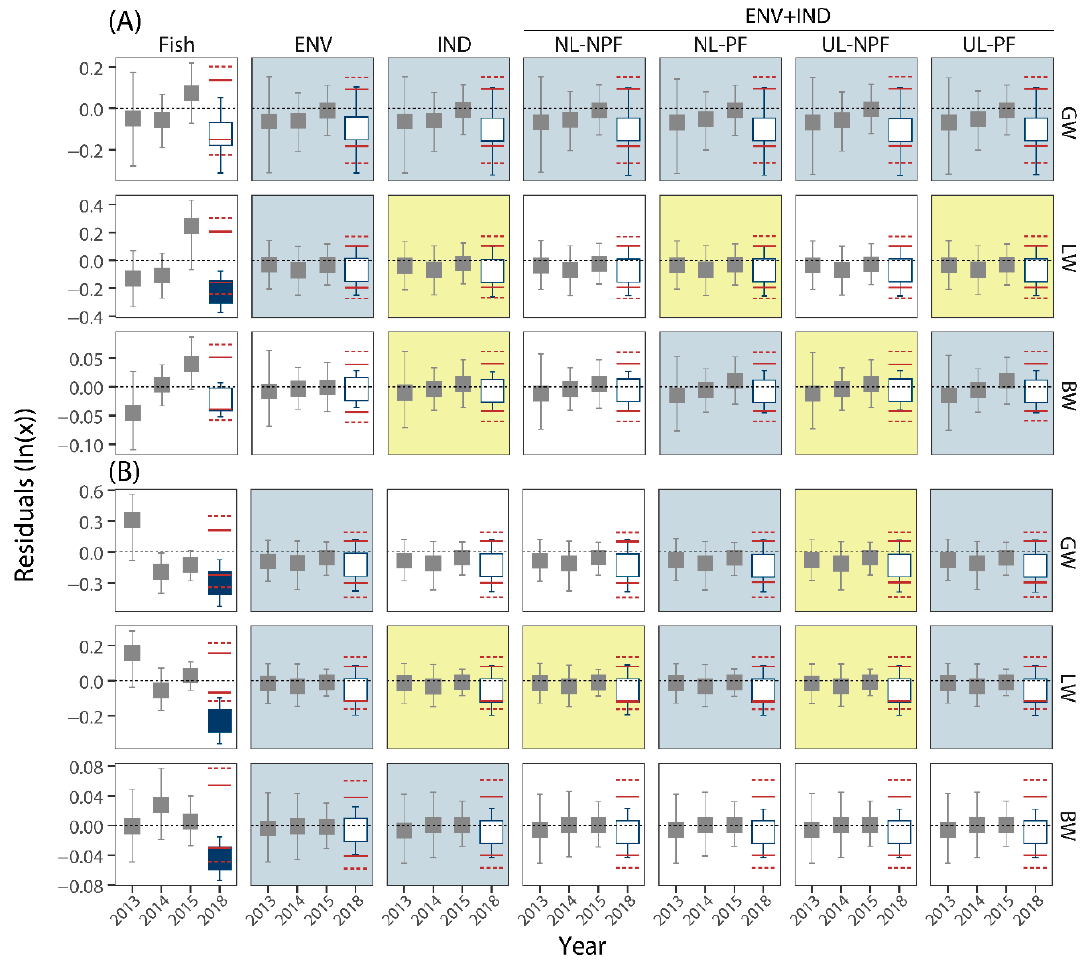
Figure 2. Mean residuals of female endpoints measured at the Upper Ells ( A ) and Lower Ells ( B ) locations; 2013:2015 (gray symbols) are reference years; 2018 is the test year; red horizontal dashed and solid lines show expected ranges of mean residuals in 2018 given the reference data; open symbols suggest no difference in mean residuals; closed symbols suggest a difference in 2018; ‘Fish’ panes include no environmental or industrial covariates; ‘ENV’ includes environmental covariates only; ‘IND’ includes industrial covariates only (with no limits and no penalty factors); ENV+IND with no limits and no penalty factors (‘NL ‐ NPF’); ENV+IND with no limits and penalty factors (‘NL ‐ PF’); ENV+IND with upper limits and no penalty factors (‘UL ‐ NPF’); ENV+IND with upper limits and penalty factors (‘UL ‐ PF’); blue shading of panes indicates the most parsimonious models se ‐ lected by AIC; yellow shading indicates marginally relevant models selected by AIC.